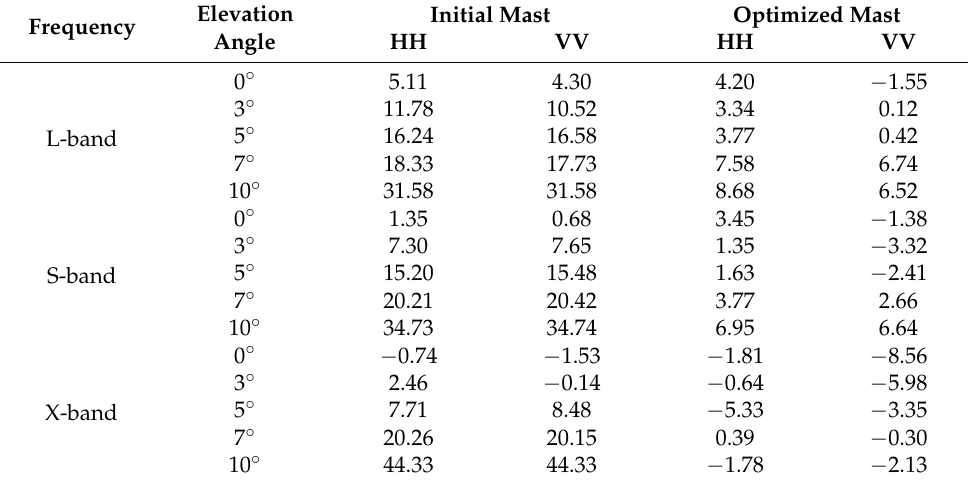
Table 2. Arithmetic mean of the integrated mast. (Unit: dBsm). Frequency